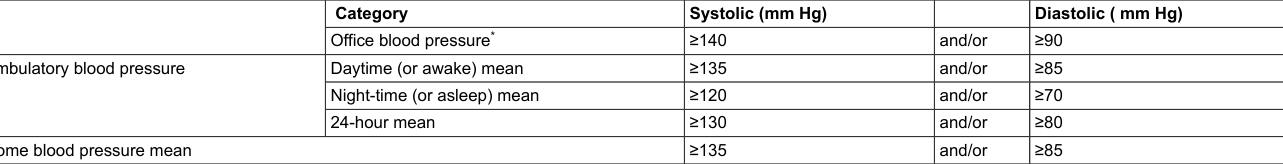
Table 3: Definition of hypertension according to office, ambulatory and home blood pressure levels (modified from Williams et al. J Hypertens. 2018;36:1953-2041 [36]).